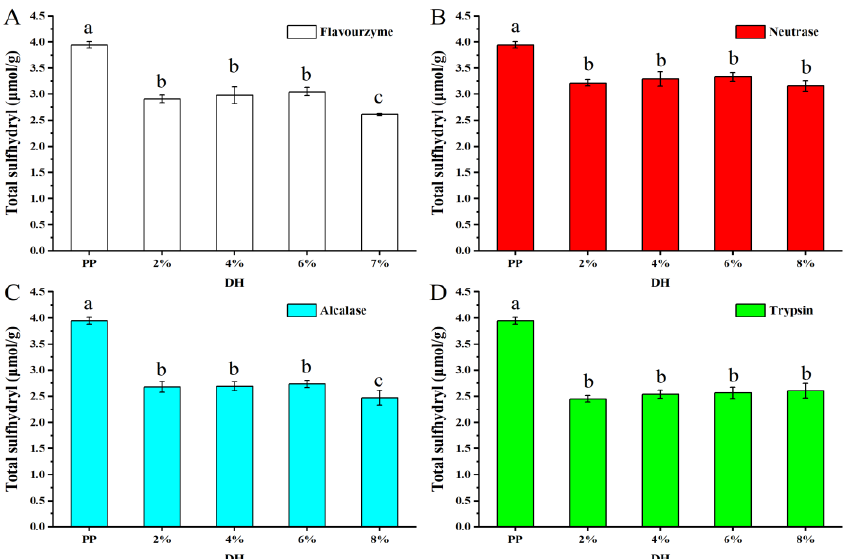
Figure 6. Total sulfhydryl content of PP and PP with different DH samples. The values reported represent means ( n = 3) ± standard deviations and different superscript letters indicate significant difference ( p < 0.05). (( A – D ) are flavourzyme, neutrase, alcalase and trypsin treatment, respectively).